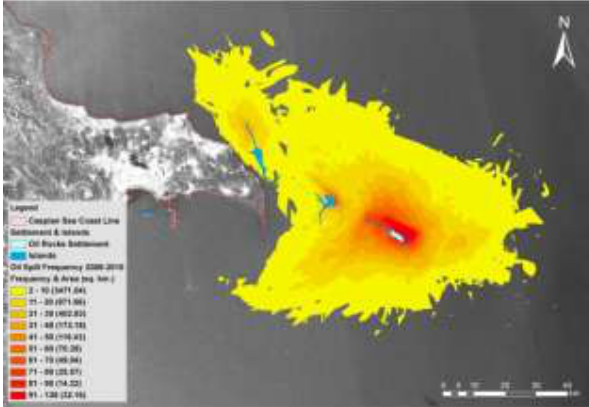
Figure. 8 Map of Oil Spill Frequency around the Oil Rocks, Chilov and Pirallahi Islands in